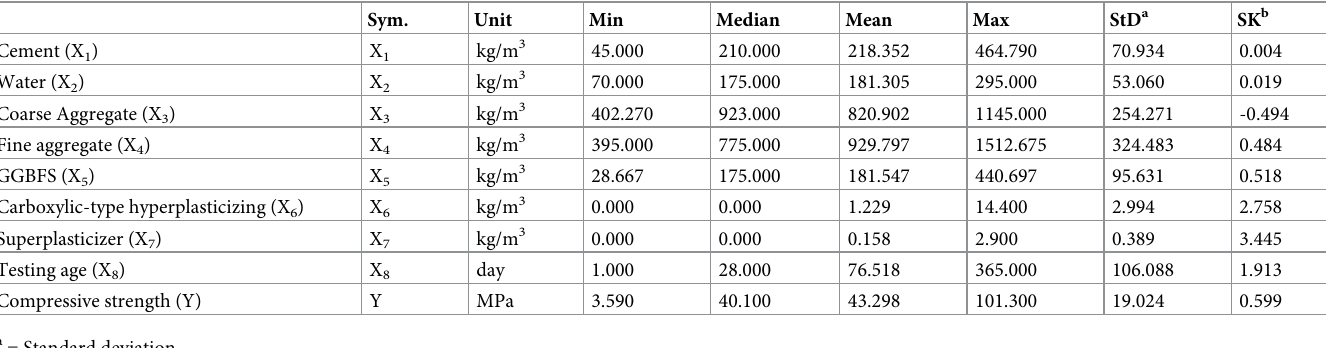
Table 2. Summary of the input and output